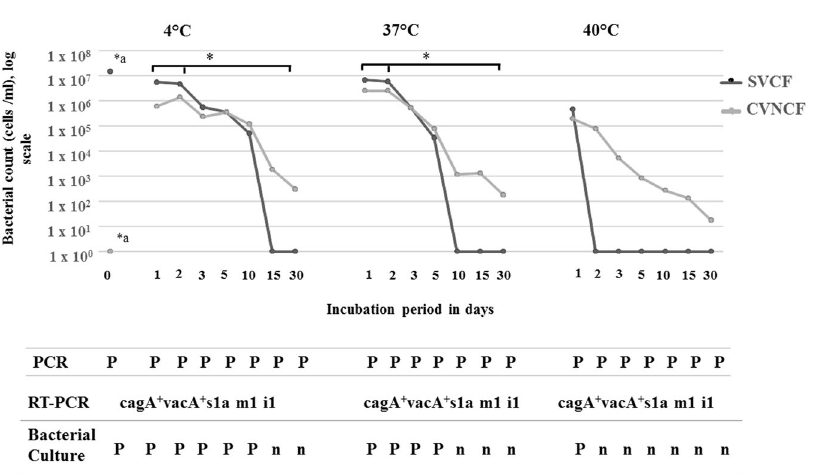
Figure 5. Survival of Helicobacter pylori in experimentally contaminated UHT milk. UHT milk was artificially inoculated with cytotoxic spiral viable culturable form (SVCF) of H . pylori strains (1.5 × 10 7 cells/ml, 0 hour) of the genotype cagA + vacA + s1a m1 i1 isolated from cow fecal samples. The milk was incubated at 4 °C, 37 °C and 40 °C for a time period from 1 to 30 days. After each time period, the numbers of the spiral viable culturable form (SVCF) and coccoid viable non-culturable form (CVNCF) present in milk were counted using a haemocytometer. * a indicates a significant difference in the bacterial count between 0 hour and all other time points, * with horizontal lines indicates significant differences between day 1 as well as day 2 and the subsequent days (day 3 to 30 days) using Repeated Measures ANOVA. The milk was further subjected to PCR, bacterial culture and reverse transcription PCR (RT-PCR); P indicates positive, n means